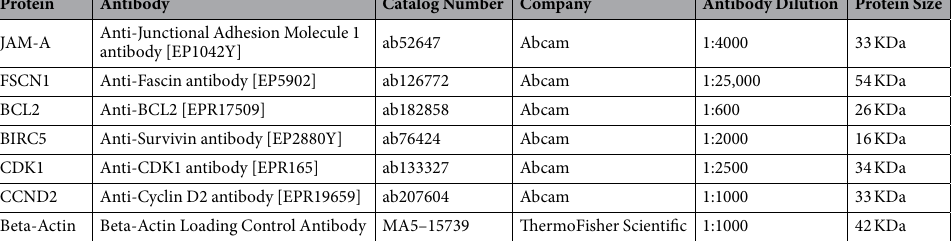
Table 3. List of primary antibodies used for western